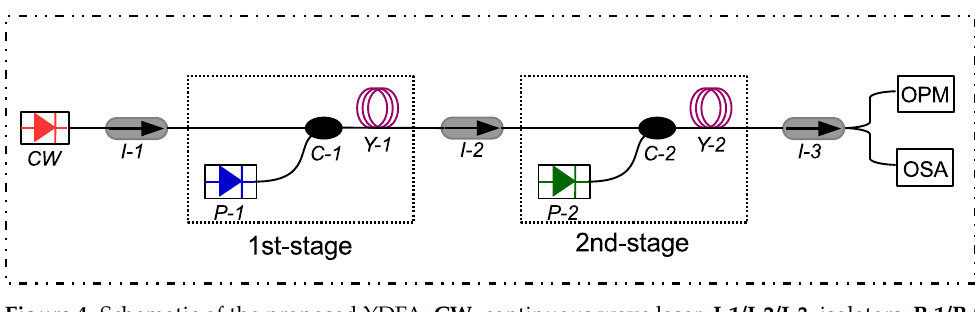
Figure 4. Schematic of the proposed YDFA: CW , continuous wave laser; I-1/I-2/I-3 , isolators; P-1/P-2 , pumps; Y-1/Y-2 , YDFs; C-1/C-2 , WDM couplers; OSA , optical spectrum analyzer; OPM , optical power